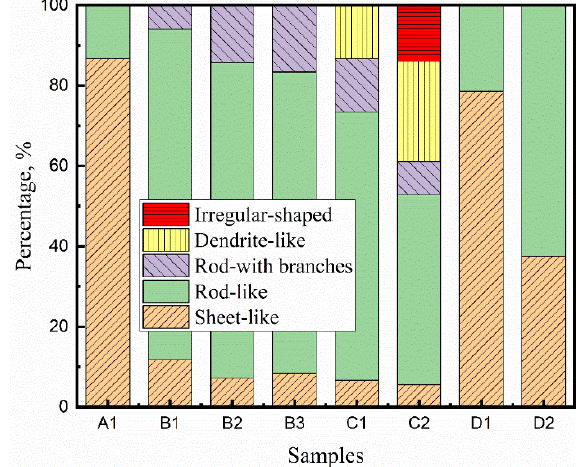
Figure 7. Number percentage of each inclusion morphology in each sample.